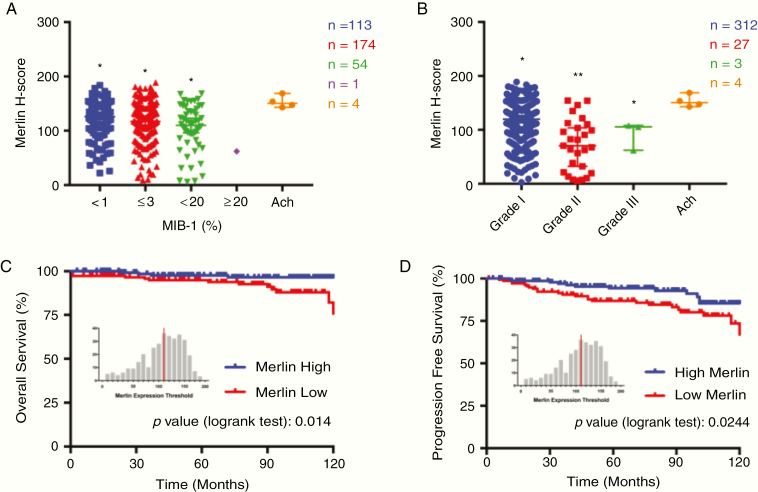
Low Merlin expression is associated with meningioma proliferation and poor clinical outcomes. (A) Merlin expression in meningioma patients with different mitotic activity. N = 346, *P < .05, ANOVA. (B) Decreased Merlin expression was significantly correlated with the increased pathological grade. N = 346, *P < .05, ANOVA. (C and D) Decreased Merlin is associated with worse outcome in patients with meningioma. Patients were split by median expression of Merlin over the entire meningioma data set (313 patients). Patients with lower than median expression of Merlin (n = 160) are denoted in red, and those with higher than median expression of Merlin (n=153) are in blue.